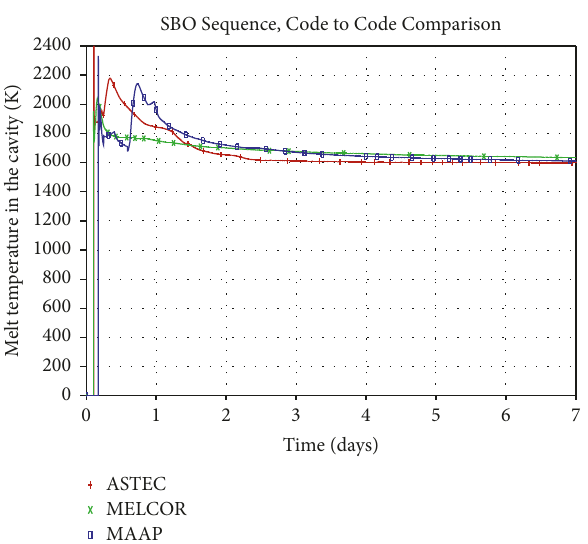
Figure 20: Heat flow from the corium to